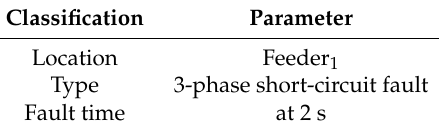
Table 3. The fault scenarios.